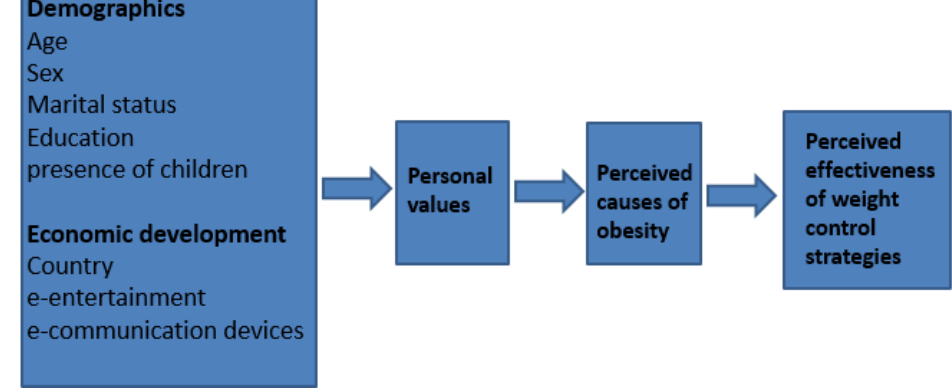
Figure 1. Initial conceptual model showing hypothesised pathways between demographic, country, personal values, perceived causes of obesity and perceived effectiveness of weight control strategies.